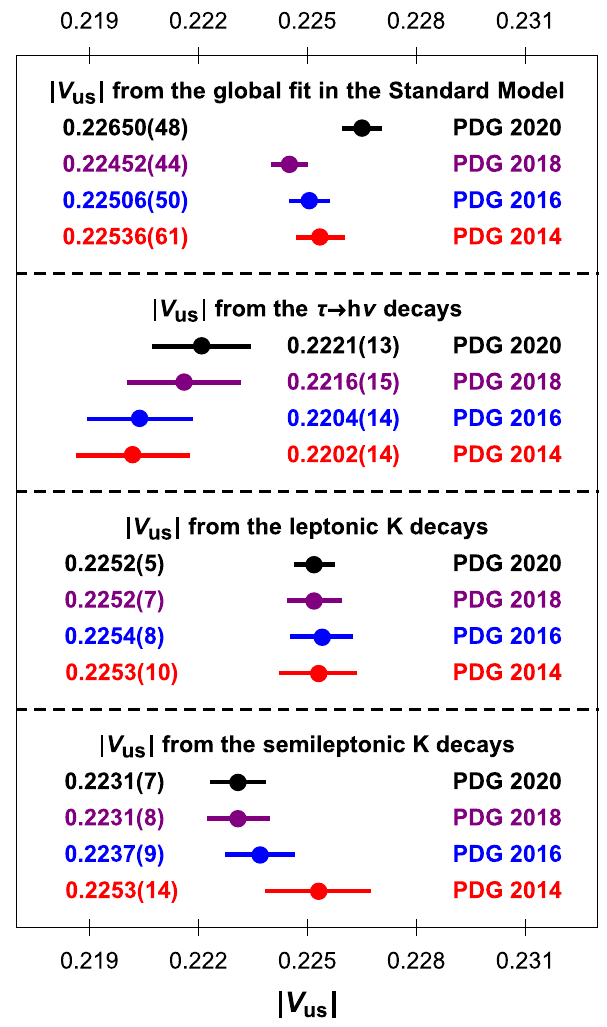
Fig. 2 The values of the CKM element | V us | from